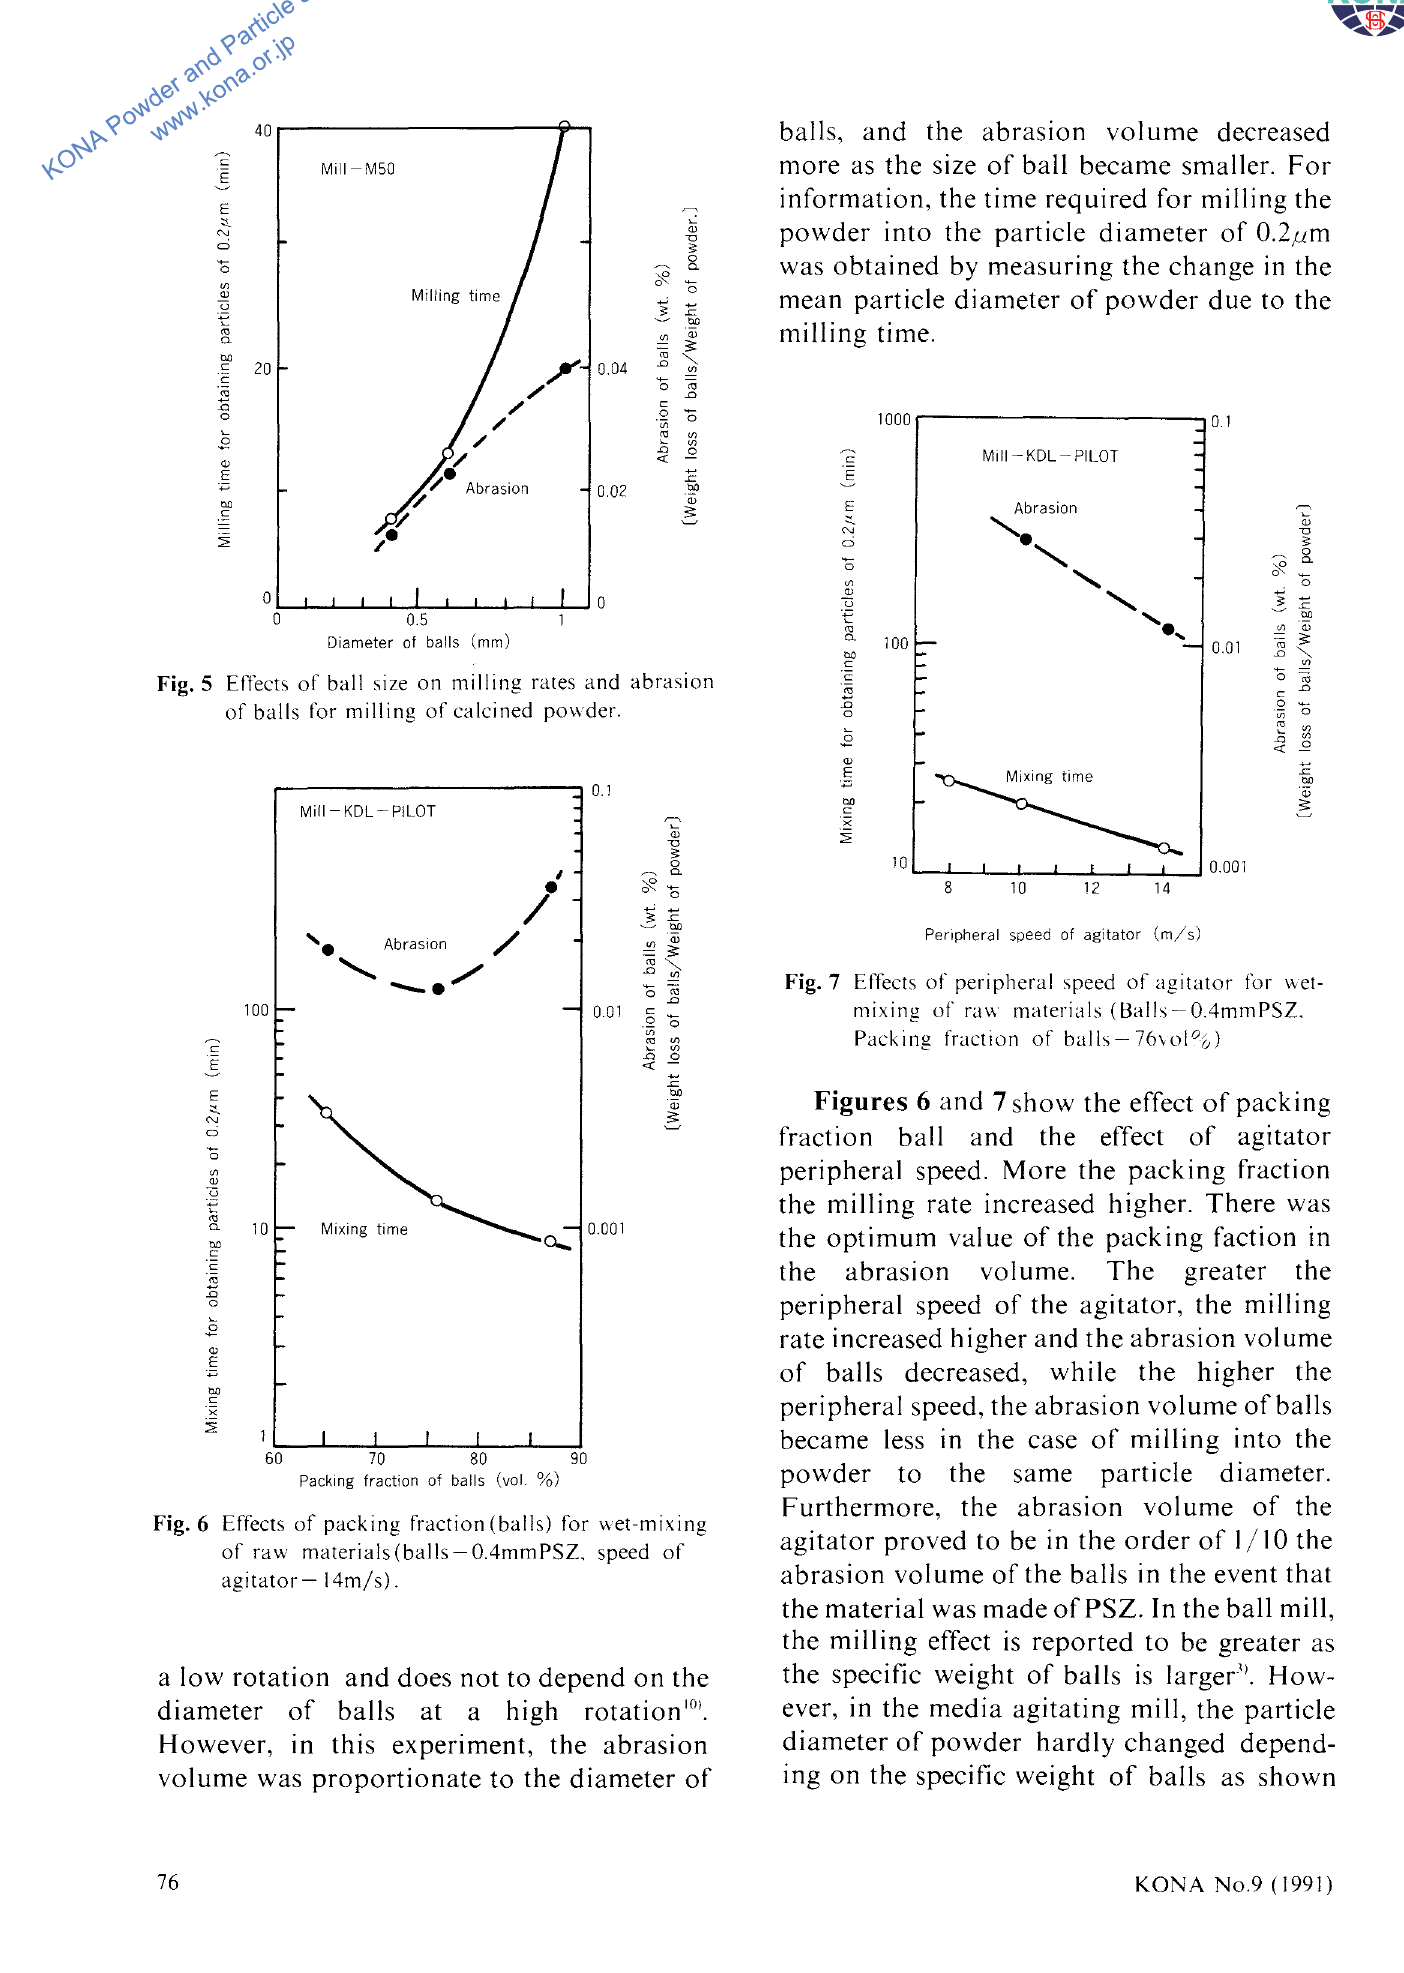
Fig. 5 EtTects of ball size on milling rates and abrasion of balls for milling of calcined powder.